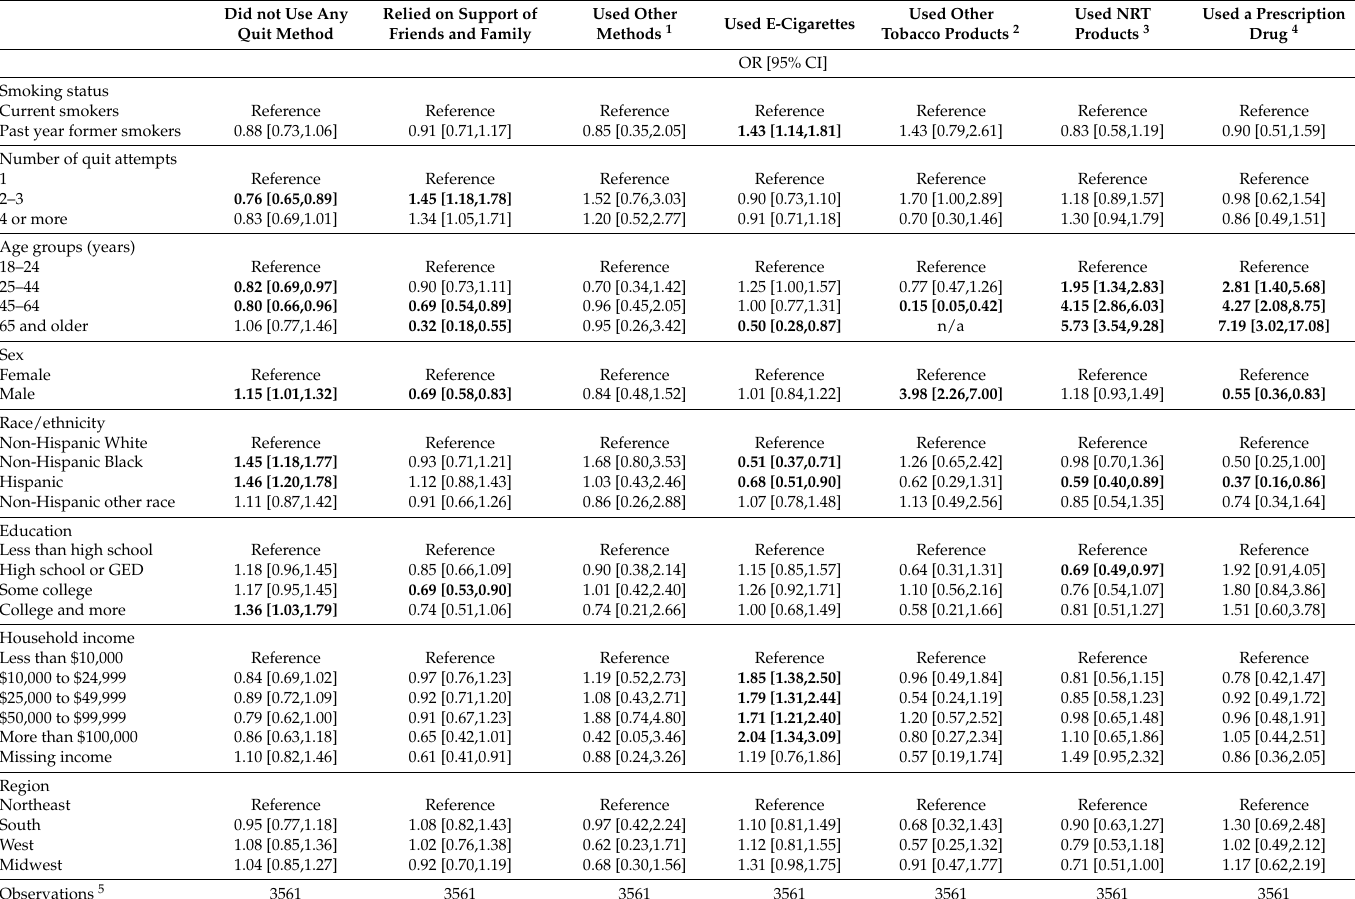
Table 4. Adjusted odds ratios (OR) and 95% confidence intervals (CI) for using each single quit method, according to smoking status and other